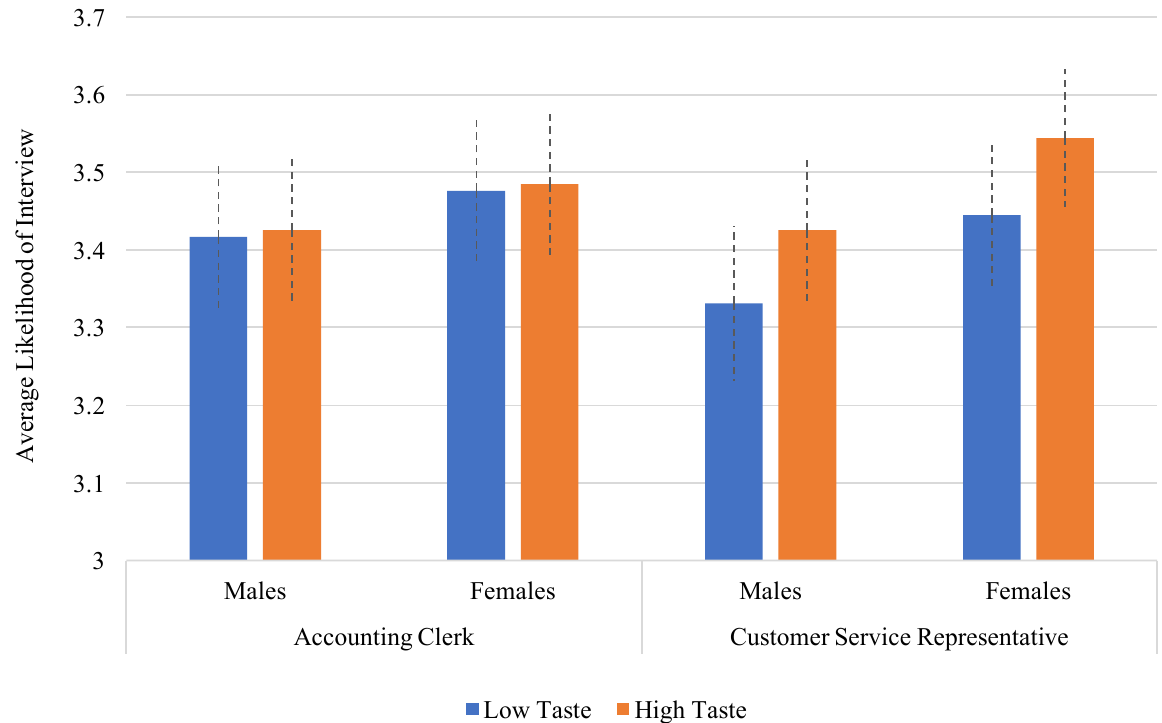
Figure 3: Effect of signals of cultural taste on likelihood-of-interview ratings. Dashed lines represent confidence